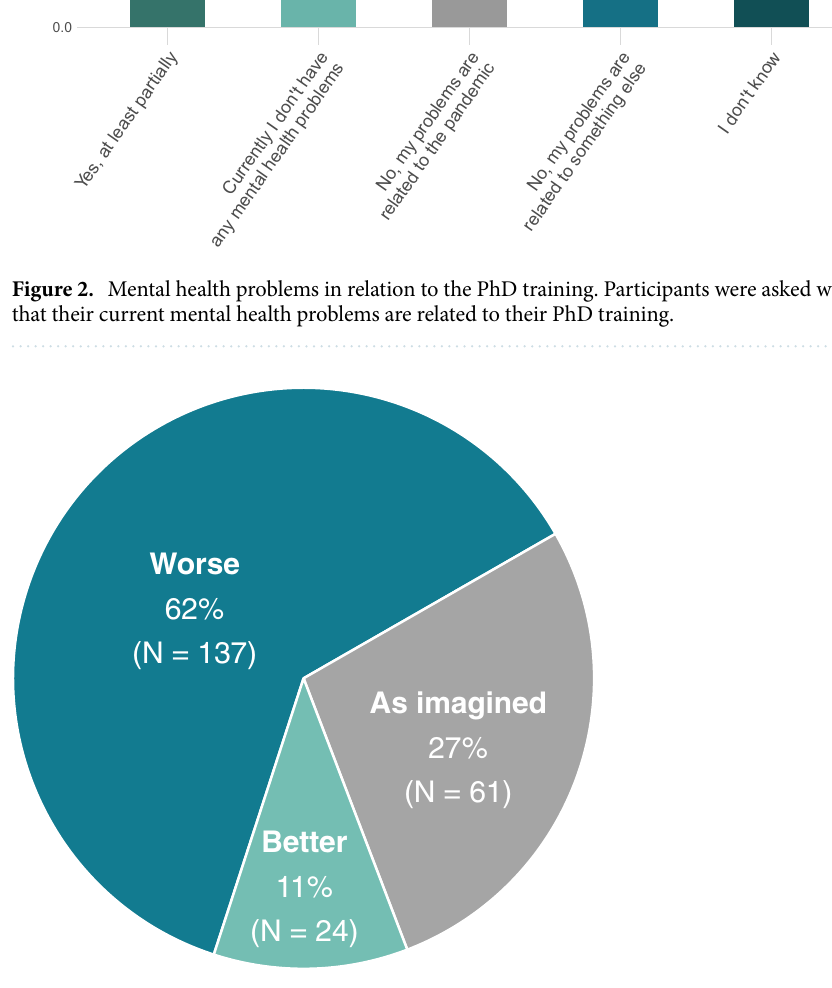
Figure 3. Expectations of the PhD training. Participants were asked whether their PhD training is how they had imagined it, better, or worse. Answers including “slightly” and “much” for both “worse” and “better” were